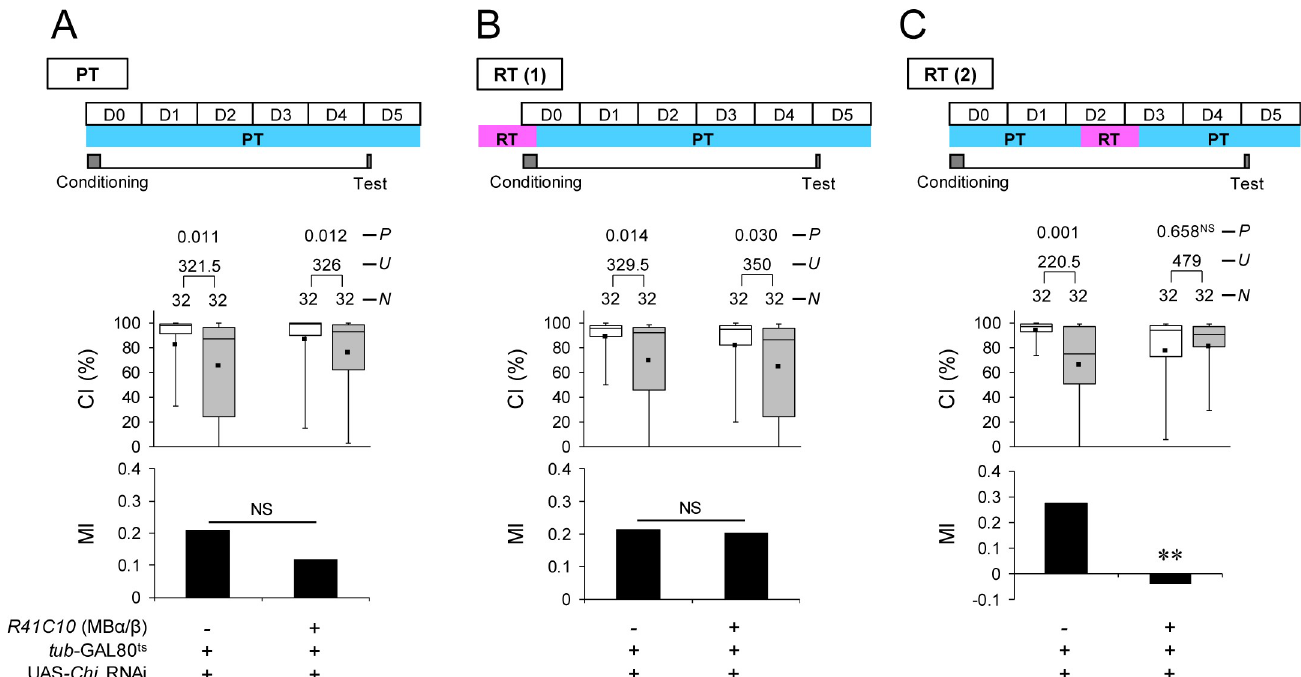
Fig 7. Temporary Chi knockdown in MB α / β neurons induces LTM impairment. (A) All experiments were performed at PT (25˚C). (B) Flies were kept at RT for 24 hours before the end of conditioning. (C) Flies were kept at RT for 48 to 72 hours after 7-hour conditioning. (A–C) Five-day memory after 7-hour conditioning. UAS- Chi RNAi (VDRC)/+; tub -GAL80 ts / R41C10 and control (UAS- Chi RNAi (VDRC)/ tub -GAL80 ts ) flies were used. Box plots for a set of CI data show fifth, 25th, 75th, and 95th centiles. In the box plots, the black square in each box indicates the mean, the line in each box is drawn at the median, the white boxes indicate naive males, and the gray boxes indicate conditioned males. The underlying data can be found in S1 Data. CI, courtship index; MI, memory index; N , sample size; U , Mann–Whitney U ; P , probability; �� , P < 0.01; NS, not significant. Chi, Chip; LTM, long-term memory; MB, mushroom body; PT, permissive temperature; RNAi, RNA interference; RT, restrictive temperature.